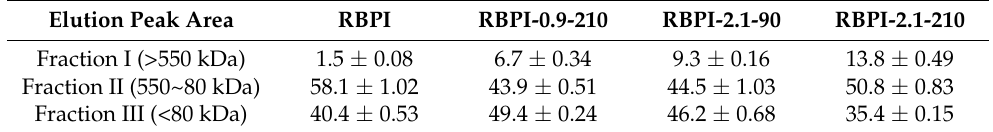
Table 2. Molecular weight distribution of RBPI prepared from different SFE pretreatment conditions (%). Elution Peak